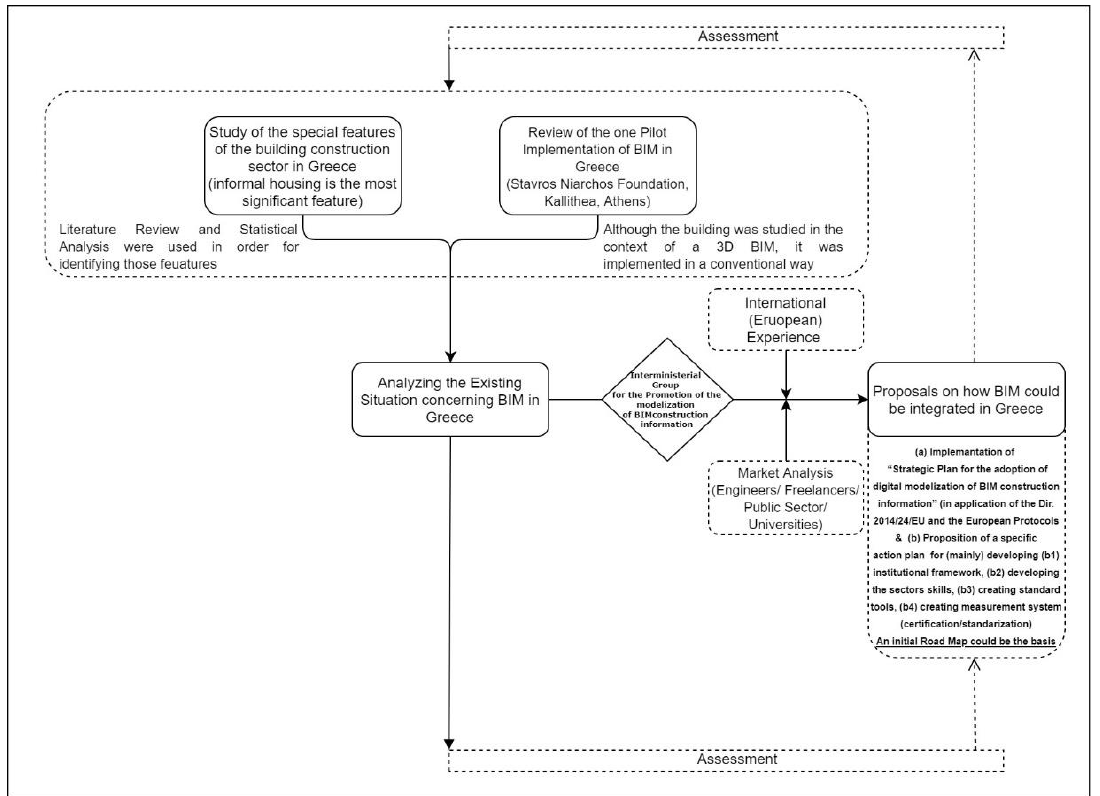
Figure 3. Research design and methodology based on the official procedures for the integration of building information modelling (BIM) in Greece. Source: own elaboration.